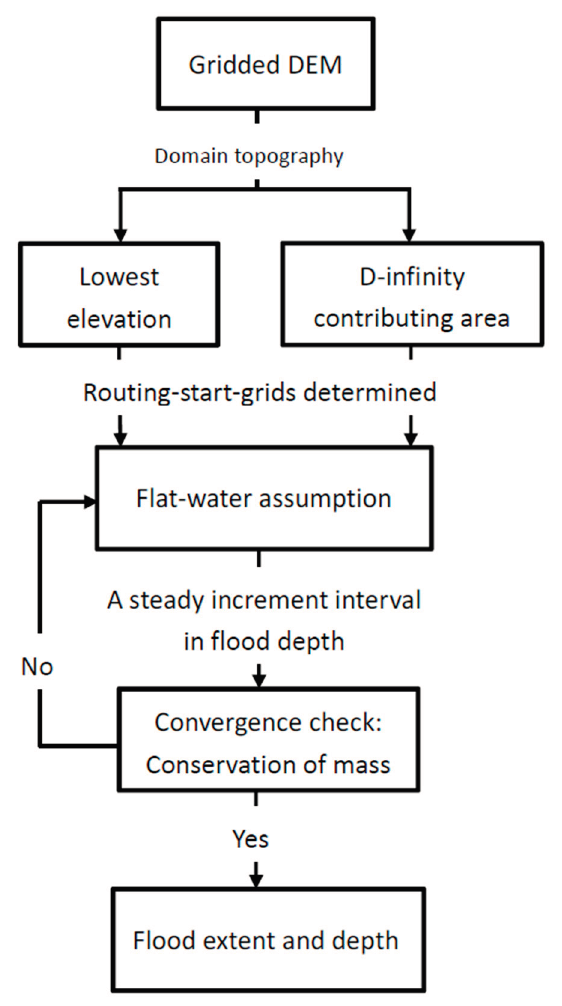
Figure 1. Overview of simplified inundation model (SPM) calculating process. (DEM—digital elevation